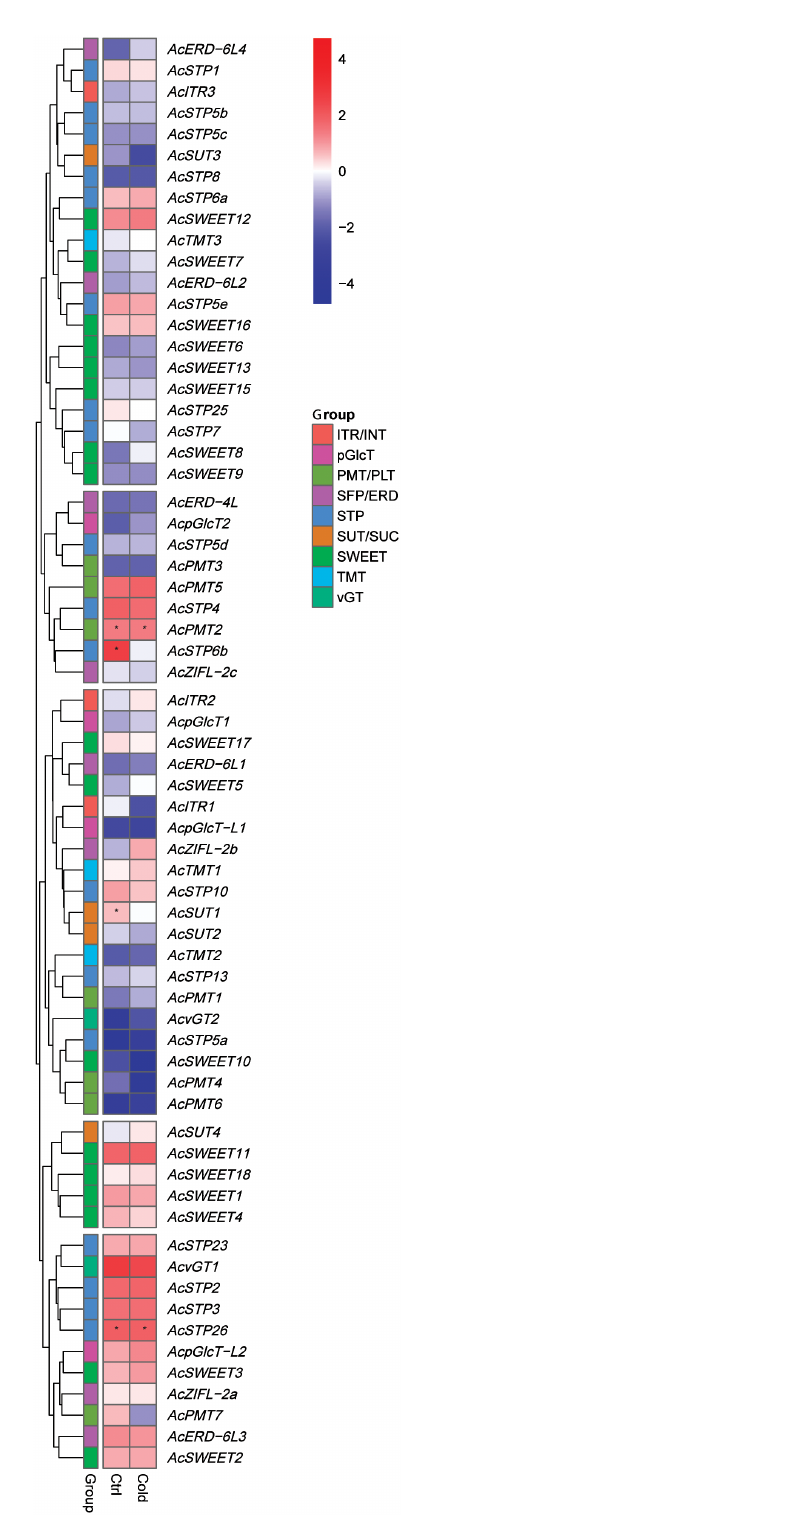
FIGURE 9 Expression pro fi le of pineapple sugar transporter genes under cold stress (4°C). High and low expression is indicated by red and blue colors, respectively, and asterisks (*) represent the FKM values above